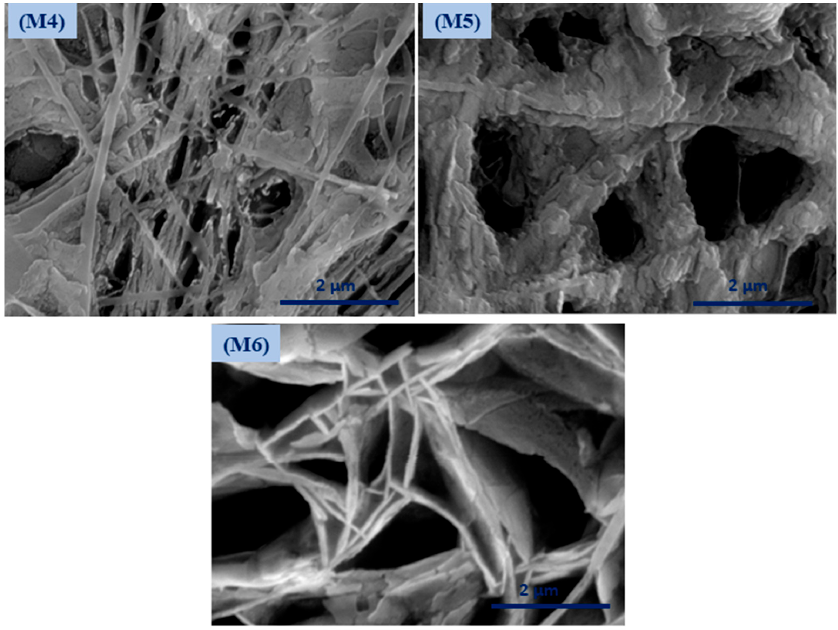
Figure 3. Surface morphology of the modified membrane by NaOH treatment.